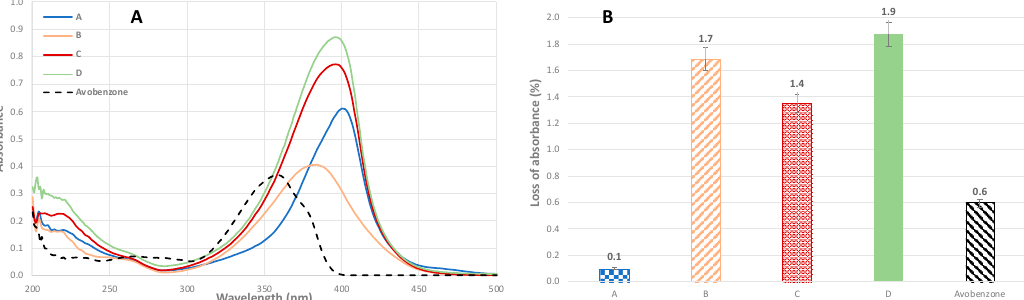
Figure 3. UV spectra ( A ) and loss of absorbance ( B ) for mixtures A , B , C , and D (individual concentration of compounds 10 µmol.L − 1 in ethanol). Table 3. EC 50 of mixtures for DPPH and tyrosinase